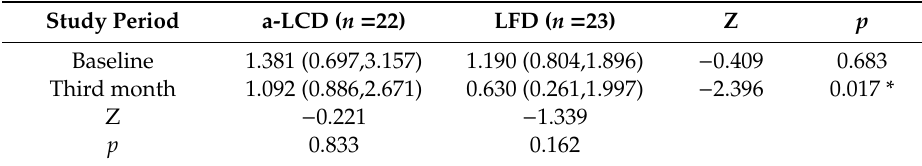
Table 7. Comparison of GLP-1[M(P25,P75)], (pmol / L)] in the two